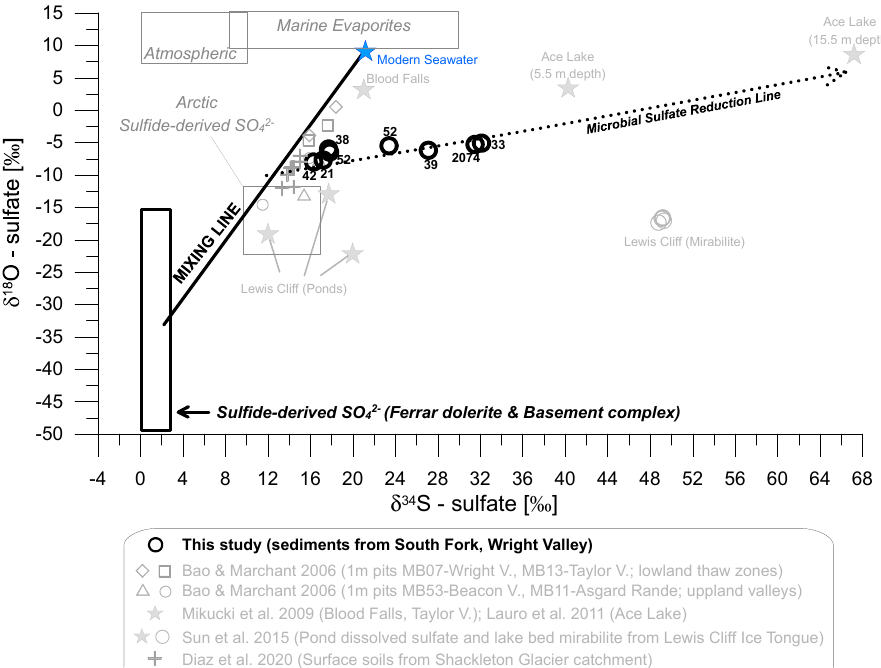
Figure 2. Comparison of δ 34 S and δ 18 O in secondary sulfate salts between the South Fork of Wright Valley (this study, black circles) and other areas of Antarctica (light gray symbols) studied by previous investigators [7–9,31]. Because of small isotopic variations with depth, average values are presented for sites no. 33 and 42. The hypothetical mixing line is presented for the sulfide- and atmospheric (sea aerosols)-derived sulfate inputs for the South Fork bedrock comprised of the Ferrar Group and Precambrian basement rocks. The δ 34 S of sulfide-derived sulfate is based on sulfur sequential extraction results (this study; Table 1) and δ 18 O is based on previously reported isotope compositions of surface water and groundwater [8,30,31]. Note that larger variation of δ 18 O in the Antarctic hydrological system precludes from more precise determination of the δ 18 O of sulfide-derived sulfate. Therefore, only δ 34 S of sulfides is used for quantitative estimates of sulfide-derived sulfate in the studied sediments from the South Fork catchment (see Section 5.1.2 for more details).